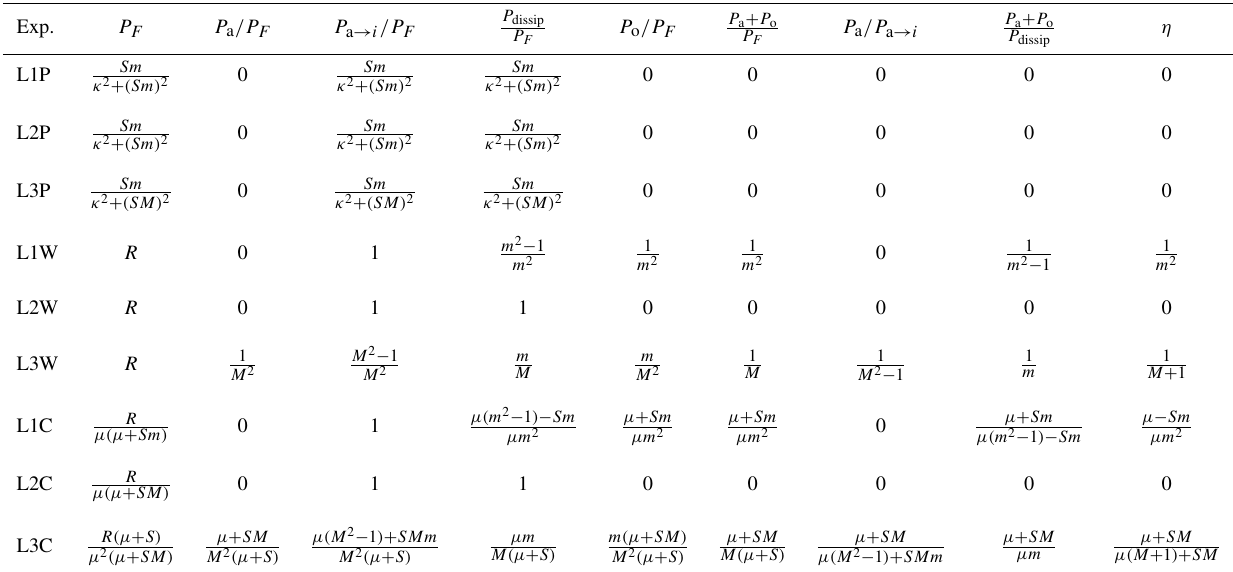
Table 1. Energy fluxes for t (cid:29) (SM) − 1 ,µ − 1 . The last column is the efficiency in the system as it compares the energy growth in the system to the energy injection. Note that for µ (cid:29) SM , LCx converges to LWx if R → Rµ 2 .